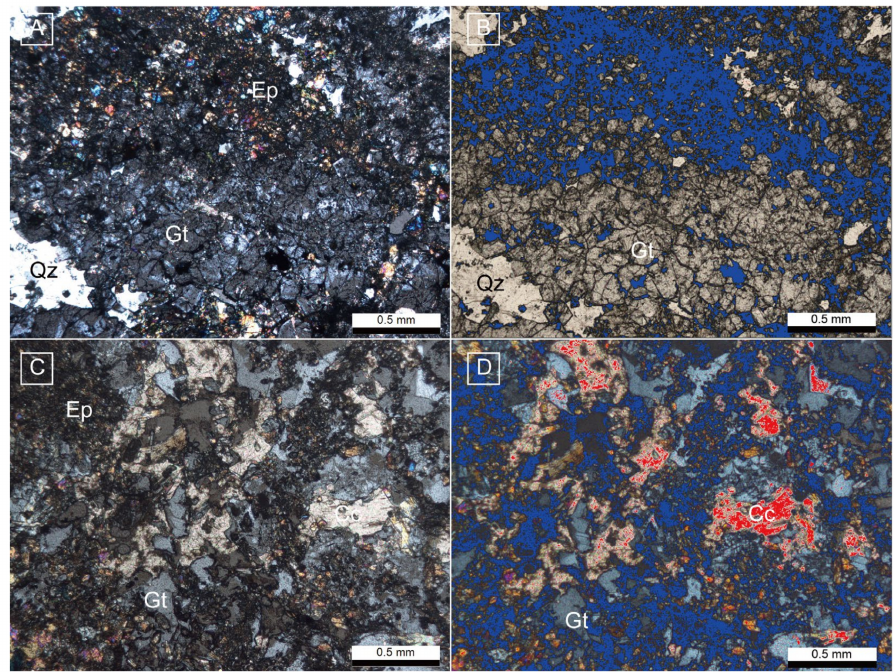
Figure 5. Microphotographs of the garnet skarn ( A , C ) are under crossed nicols; ( B , D ) are exposure- adjusted under open nicol and crossed nicol, respectively). ( A , B ) Large garnet crystal (Gt) is replaced by small epidote aggregate (Ep) and is strongly fragmented. ( C , D ) Garnet replaces calcite (Cc) and calcite remains after the replacement of